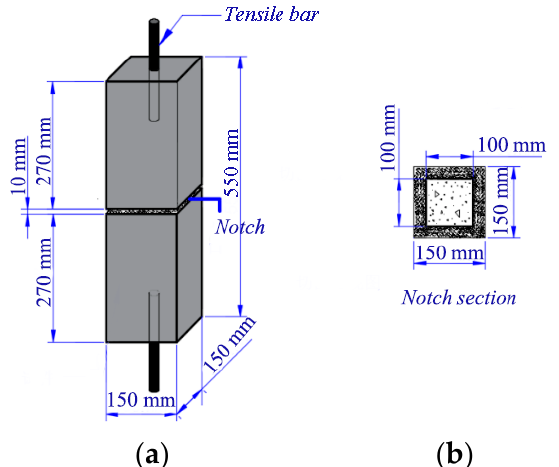
Figure 2. Specimens of axial tensile test: ( a ) notched specimen with tensile bars; ( b ) notch section of specimen.